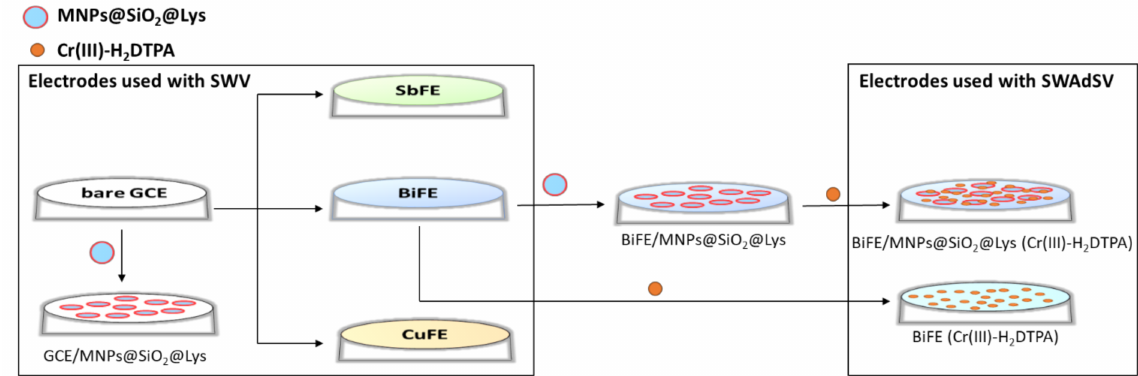
Figure 1. Schematic representation of the electrode